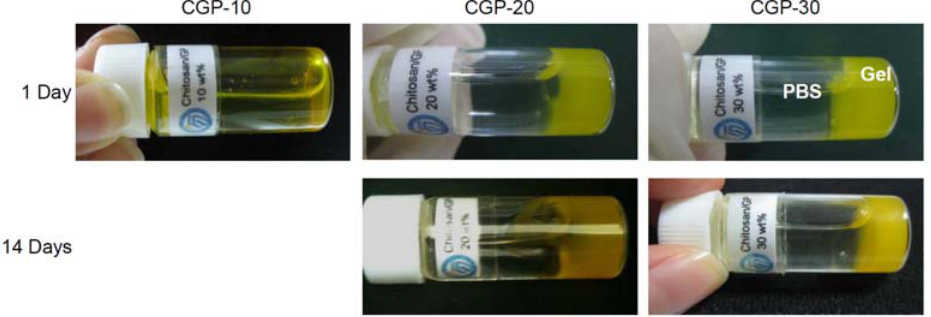
Figure 4. Images of BSA-FITC-loaded CGP-10, CGP-20 and CGP-30 at 37 °C after the addition of 37 °C